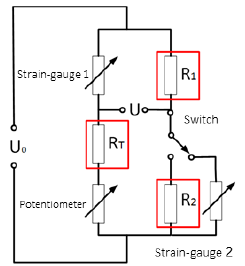
Figure 2. Electrical circuit scheme of the realized Wheatstone bridge.